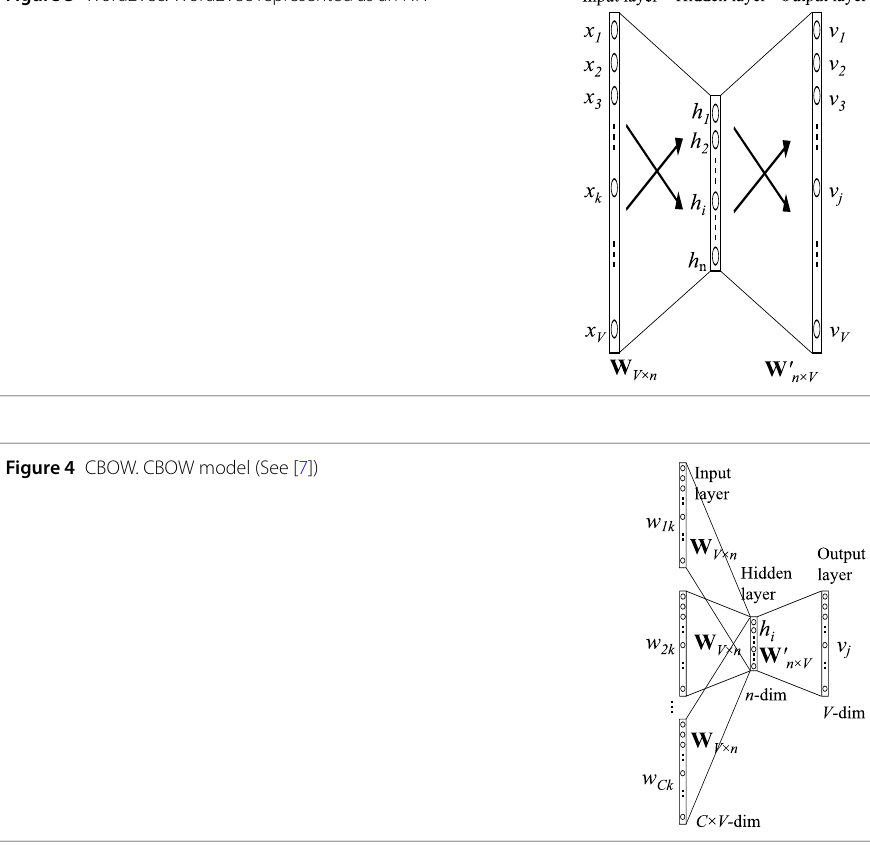
Figure 3 Word2vec. Word2vec represented as an NN